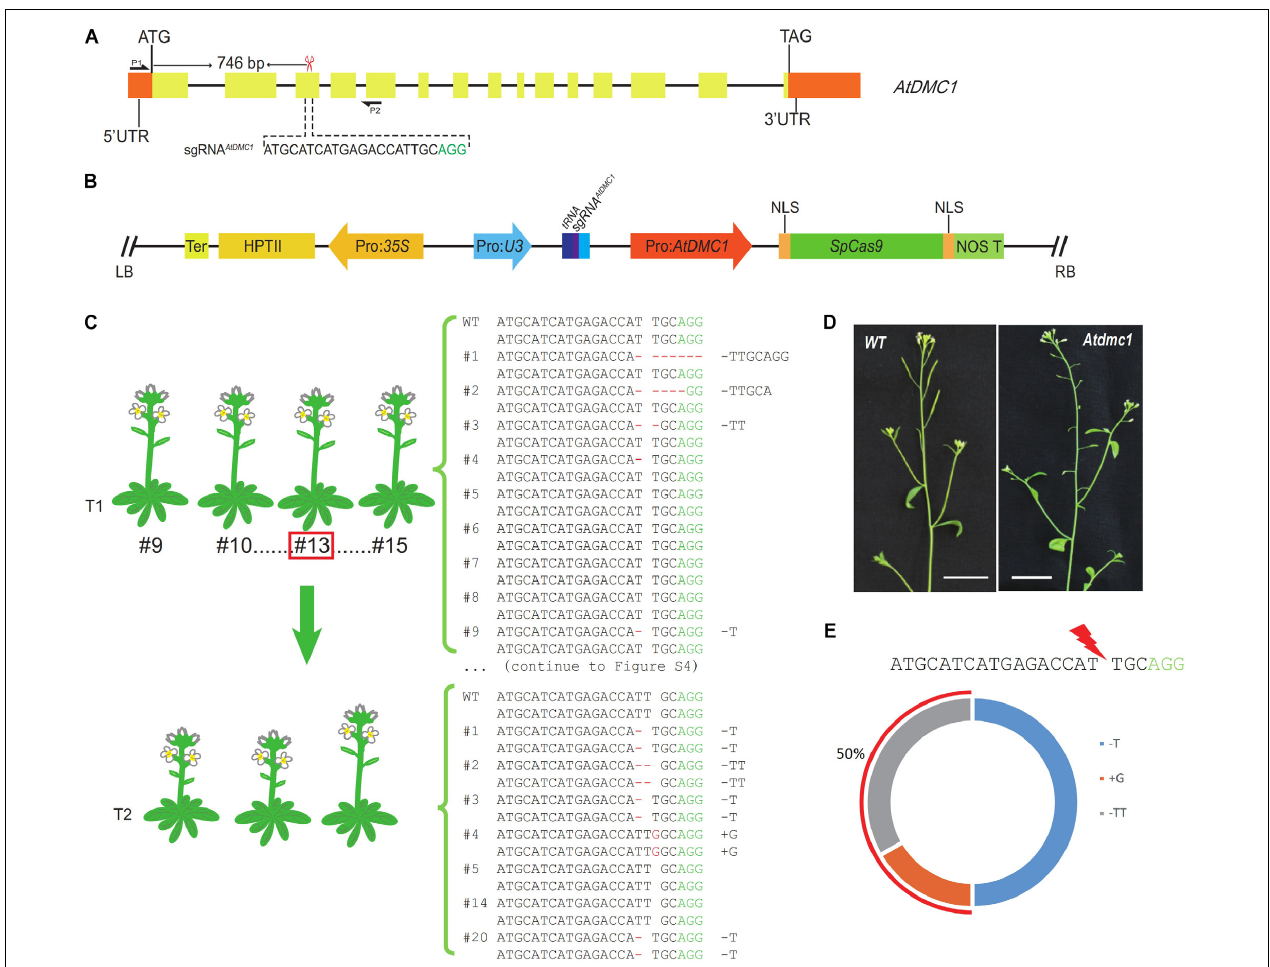
FIGURE 3 | Genotypic and phenotypic analyses of targeted mutations generated by the MSC system for AtDMC1 in Arabidopsis. (A) The targeted site in the AtDMC1 genomic region. The sgRNA AtDMC1 was located in the third exon (746 bp downstream of the start codon). The sgRNA AtDMC1 sequence was shown in black and PAM in green. The red scissor indicates the targeted position. P1 and P2 showed the primers used for amplifying the DNA fragment covering the targeted site. (B) The map of pLFC290 plasmid. An illustration of the SpCas9 endonuclease driven by Pro: AtDMC1, and the sgRNA AtDMC1 driven by Pol-III promoters U3 . (C) Sanger sequencing results of Atdmc1 mutants generated by the MSC system in T1 and T2 generation. In the T1 generation, heterozygosity rate is 69% (9/13). The analyzed T2 population was derived from the parent line #13 (framed by a red square). Heterozygosity rate is 86% (6/7) in the T2 generation. (D) The phenotypes of the wild type plant and the targeted editing Atdmc1 mutant in T2 population. The mutant’s siliques are shorter than wild-type ones, suggesting the fertility is affected. Bar = 1 cm. (E) The genotypic statistics of T2 plants. 50% of the targeted editing mutations are newly mutations. Another 50% were inherited from the parental plant line #13